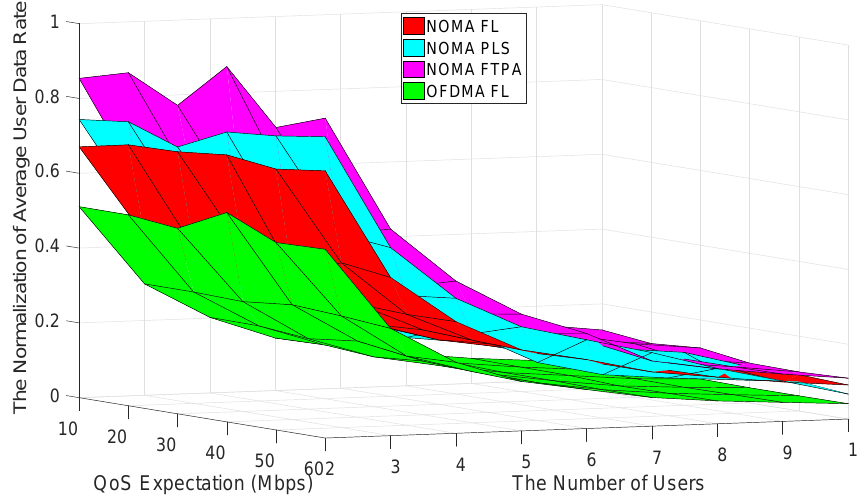
Figure 8. 3D plot with varied QoS, number of users, and AUDR.